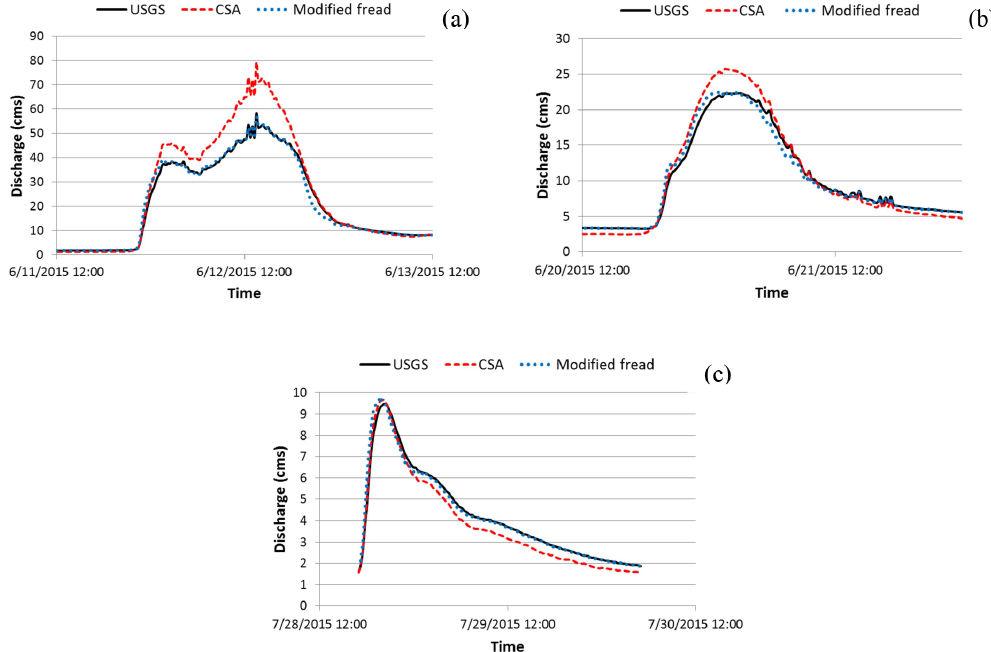
Figure 9. Comparison of discharge hydrographs based on the USGS, CSA, and modified Fread methods for the selected three events: